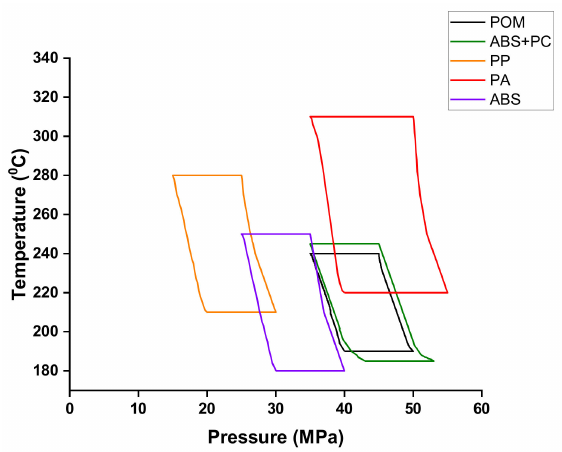
Figure 9. The mold window for the micro-sized part using POM, ABS, PP, PA, and ABS + PC materials by precision injection molding.